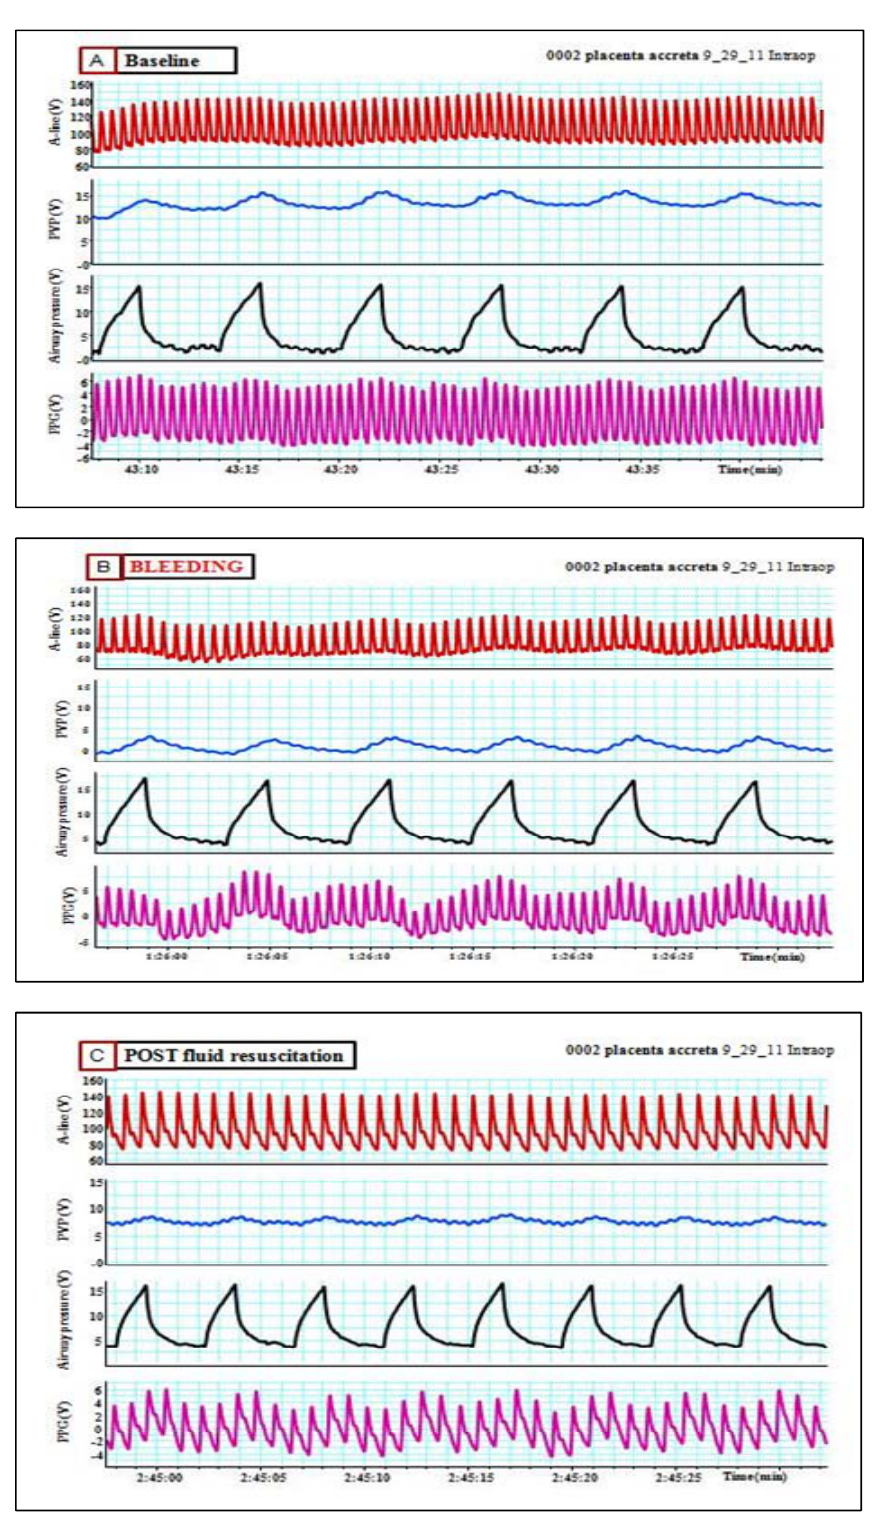
Figure 12. ( A ) (upper panel): Baseline ; arterial blood pressure (A-line), peripheral venous pressure (PVP) and plethysmographic waveforms during volume controlled mechanical ventilation. ( B ) (middle panel): Post bleeding ; notice the drop in the peripheral venous pressure together with the respiratory modulation of arterial blood pressure and PPG waveforms. ( C ) (lower panel): Post fluid resuscitation ; shows partial restoration of peripheral venous pressure together with less oscillation of PPG and arterial blood